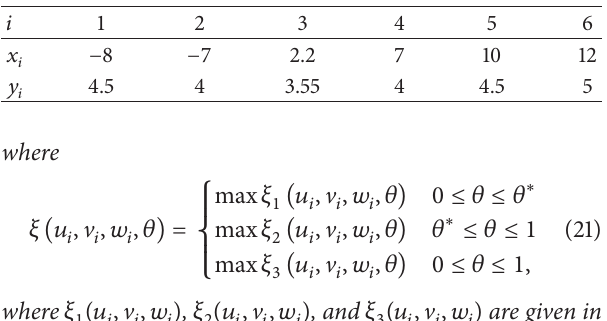
Table 7: 2D convex data